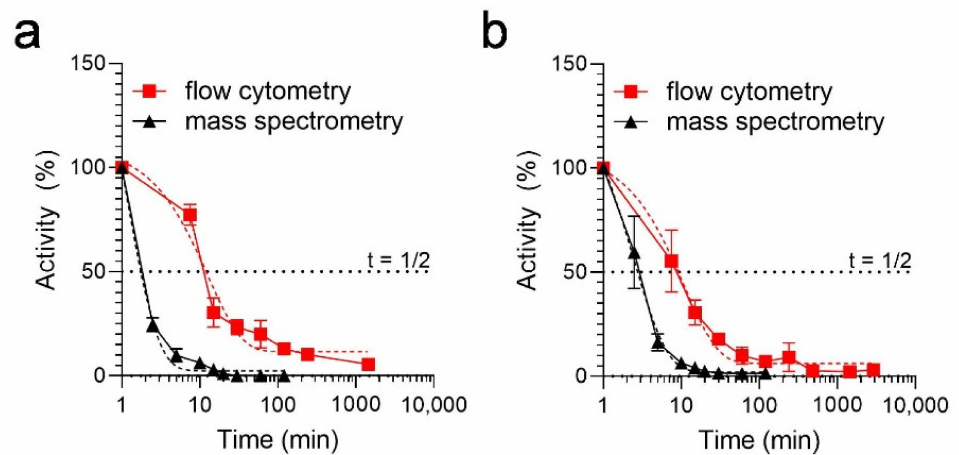
Figure 1. Half-lives of EPI-X4 WSC02 and EPI-X4 JM#21 in human plasma measured by a flow cytometry-based functional assay and mass spectrometry. For the functional assay, WSC02 ( a ) or JM#21 ( b ) were spiked into human plasma and incubated at 37 ◦ C. At indicated time points, aliquots were taken and serially diluted in cold PBS. Then, plasma/peptide dilutions were added to CXCR4 expressing SupT1 cells together with a constant concentration of APC-conjugate ECL2-CXCR4 specific antibody 12G5. After 2 h, unbound antibody was removed, and cells were analyzed by flow cytometry. Remaining activity was determined described before [16]. For detection by mass spectrometry, WSC02 (a) or JM#21 (b) were spiked into plasma and incubated at 37 ◦ C. and analyzed in LC-MS/MS. Half- lives were calculated using a one-phase decay model in GraphPad Prism. Curve fits are shown as dashed lines. Data shown are derived from 3 individual rounds of plasma incubation ±